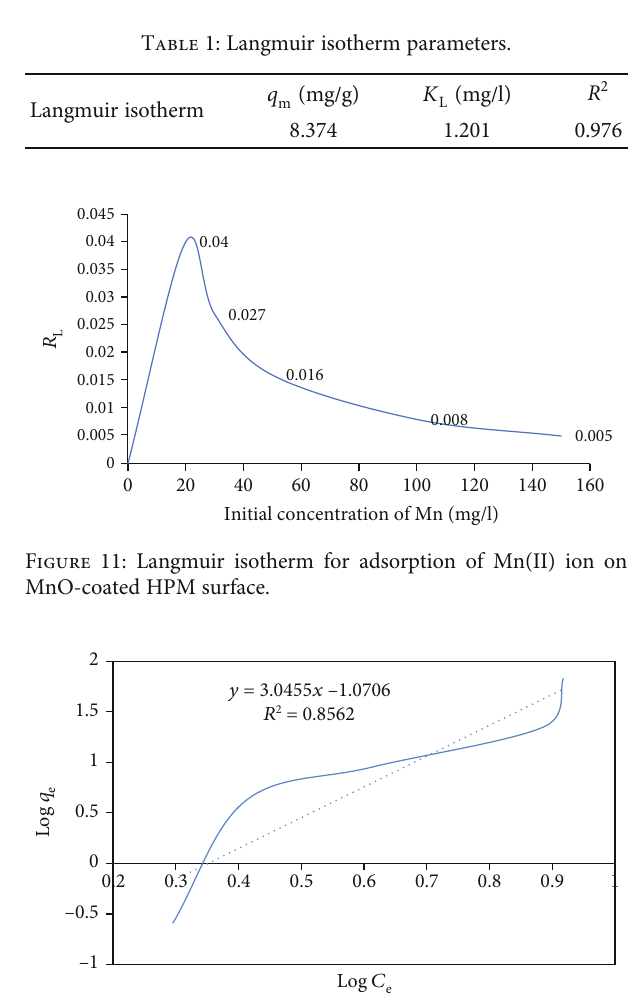
Figure 12: Freundlich isotherm as a plot of log q